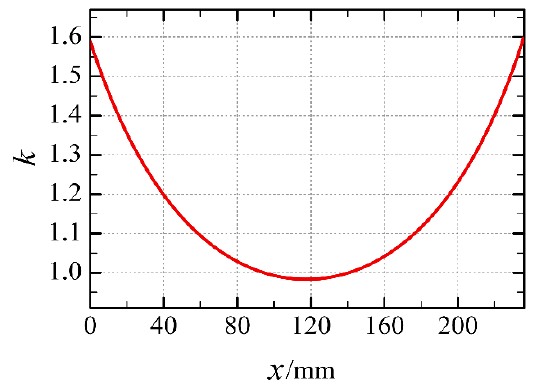
Figure 11. Distribution of the correction factor on the research subject. The direct measurement results of the irradiation reflection method were corrected by using Equation (39) and the corresponding correction factor, and the corrected results are shown in Figure 12. The lines in the figure represent the corrected measurement results for the corresponding emissivity.